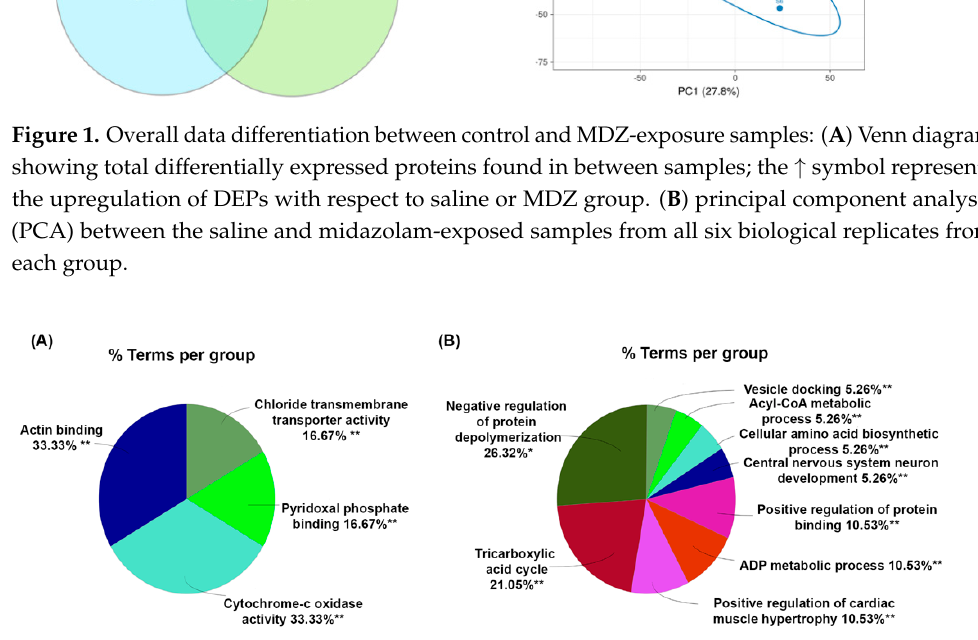
Figure 3. Ingenuity pathway analysis (IPA). Enriched pathways associated with long-term MDZ exposure. The pathways are ranked by the negative log of the FDR corrected p -value of the enrich- ment score and color-coded according to the Z score. A significantly increased pathway activity is indicated by a positive Z score, represented by the orange bars, and an overall decrease in pathway activity is represented by a negative Z score, represented by blue bars. The Gray bar represents enriched pathways with no predicted activity change.